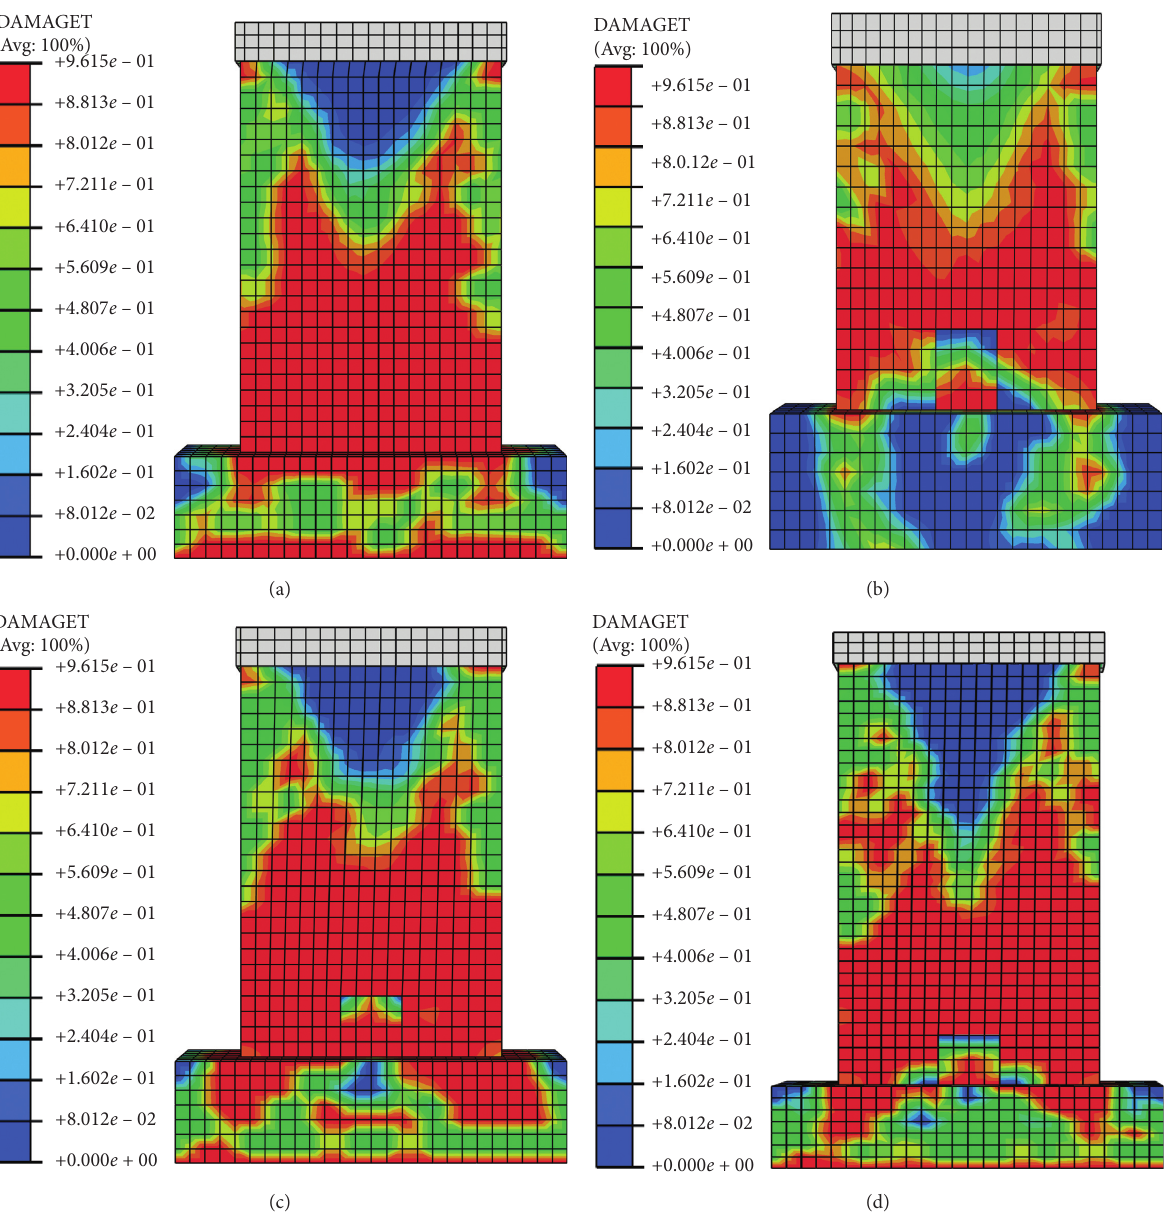
Figure 16: Tensile damage distribution diagrams of four specimens. (a) SW1. (b) TSW1. (c) TSW2. (d) TSW3. Note: DAMAGET, tensile damage distribution diagram; Avg,